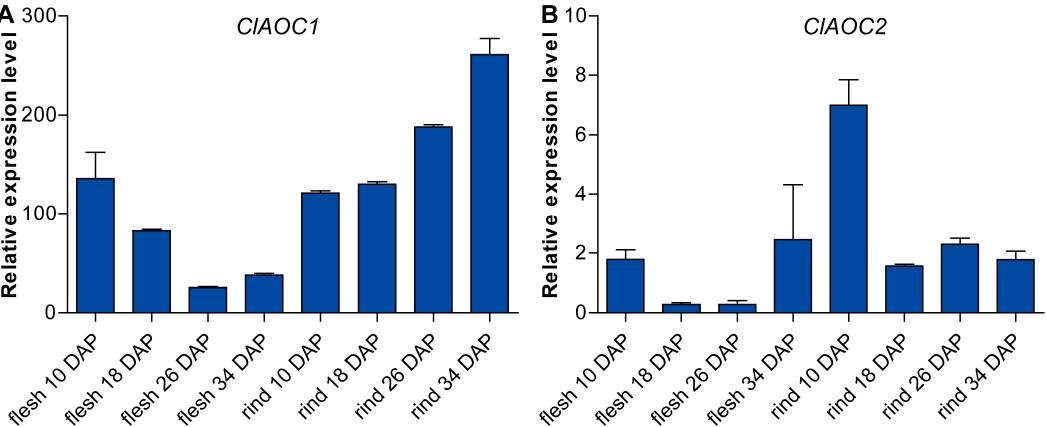
Figure 6. The expression of ClAOC1 ( A ) and ClAOC2 ( B ) during the development of flesh and rind at di ff erent stages based on the transcriptome data. The expression levels were indicated FPKM values. DAP, day after pollination.